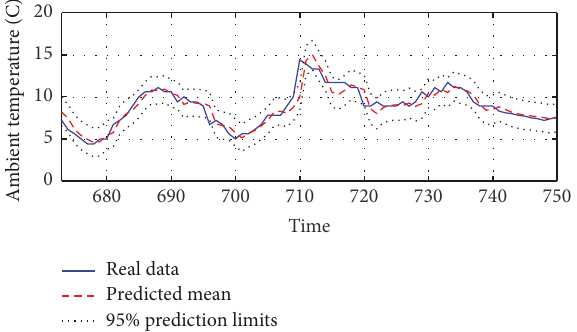
Figure 6: Prediction of ambient temperature using a time-series GP model.